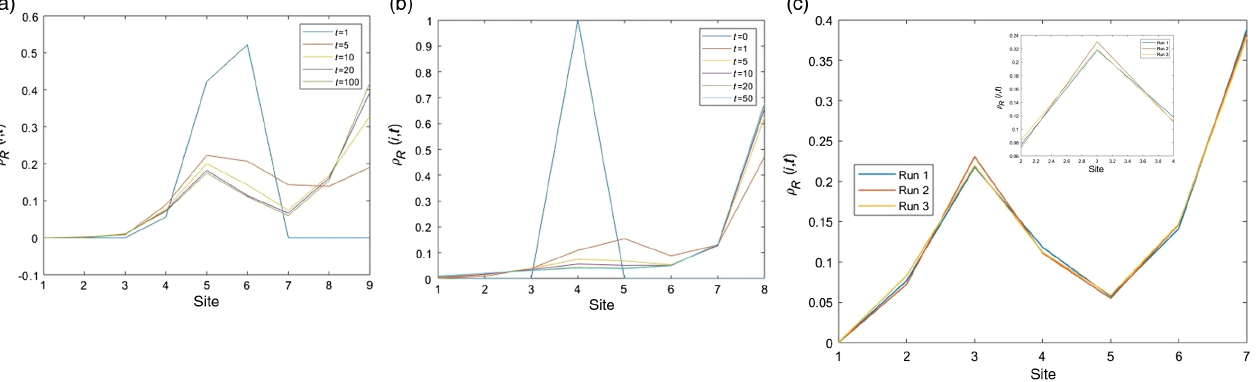
FIG. 1. (a) Right-weight profile of a spreading fracton charge operator in a system of L ¼ 9 sites with open boundary conditions subject to three-site gates. (b) Right-weight profile for an L ¼ 8 system subject to four-site gates. (c) The late-time ( t ¼ 200 ) right- weight profile for three independent runs, with three-site gates. All three runs are almost on top of each other, indicating negligible fluctuations. Inset: Enlargement of sites 2 – 4, which similarly exhibit negligible fluctuations.